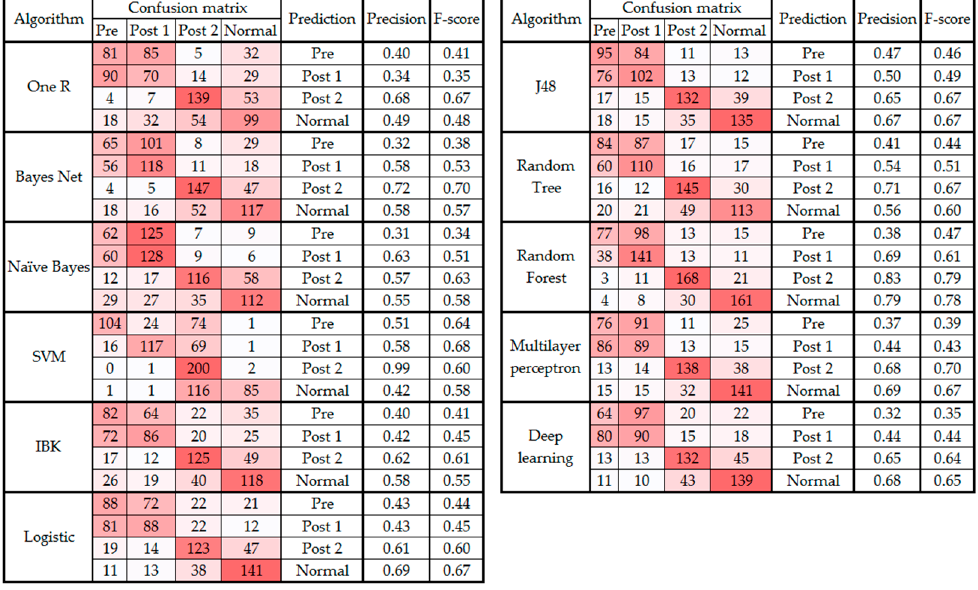
Figure 1. Confusion matrix, precision, and F ‐ score from classifying data into four classes.